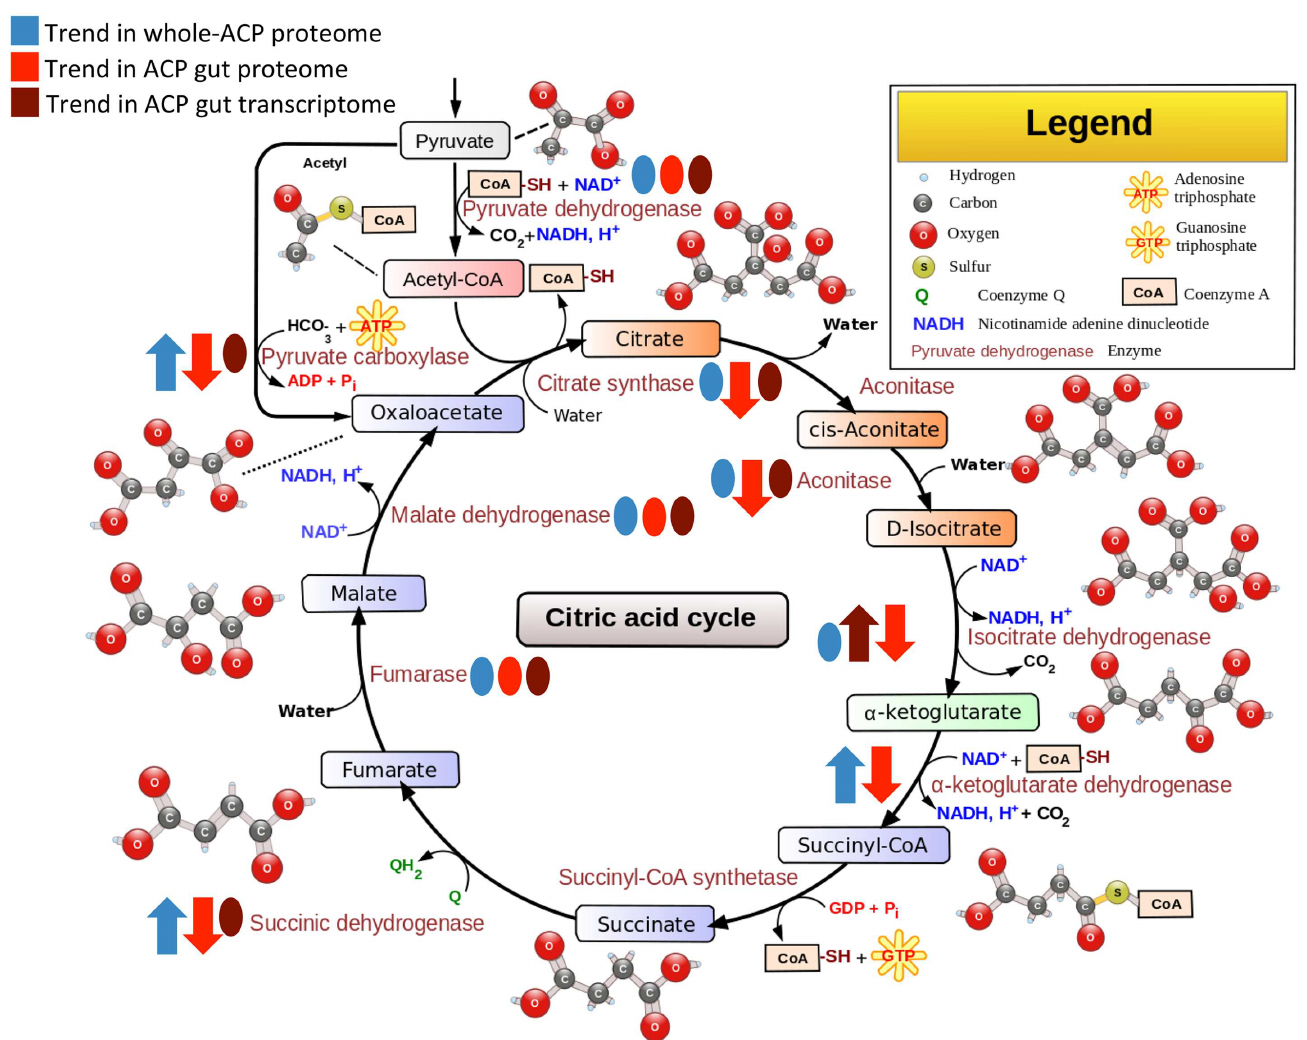
Fig 3. Schematic diagram of the citric acid cycle showing the trend of regulation in the proteome upon CLas exposure. This image was taken from https://en.wikipedia.org/wiki/File:Citric_acid_cycle_with_aconitate_2.svg and adaptedto indicate up- and down-regulationshown by proteomic and transcriptomic data using the creative commons license http://creativecommons.org/licenses/by-sa/3.0/deed.en. Blue shapes reflect the whole body ACP proteome data from [14], red shapes reflect the ACP gut proteome, and maroonshapes reflect the gut transcriptome. Arrows indicatethe trend of up- or down-regulation, and ovals indicatethat these enzymes were detected but were not differentiallyexpressed.